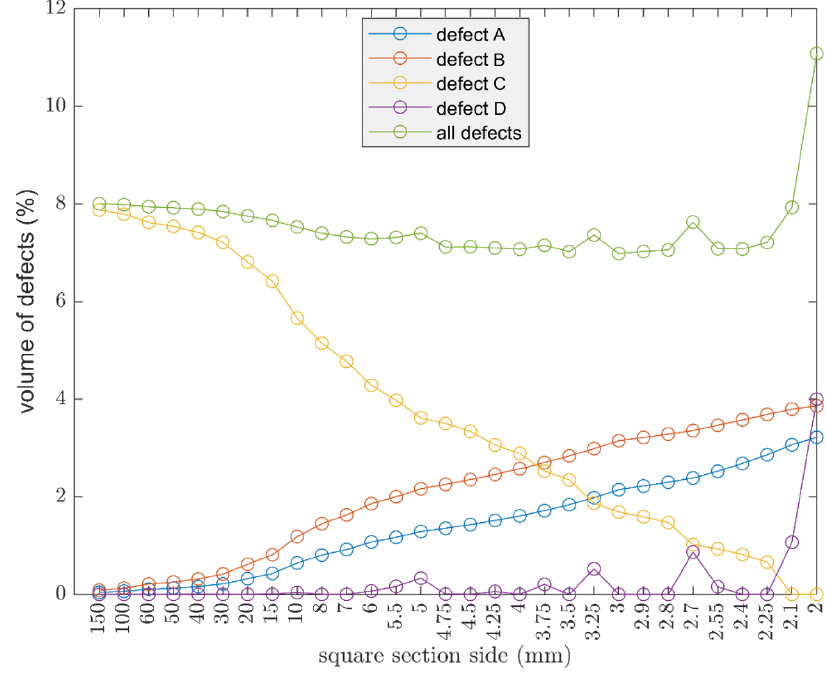
Figure 12. Influence of geometric dimension on volume of defects, layer height 0.15 mm, width 0.4 mm, 2 shell (contour) lines, raster angle 45°.